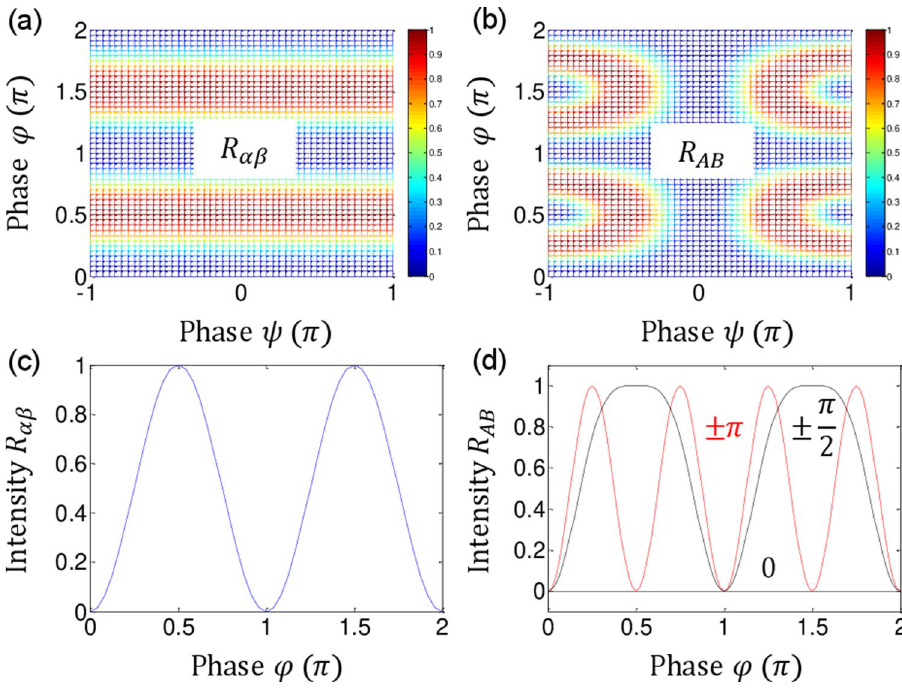
Figure 3. Numerical calculations for normalized intensity product R ij for Fig. 2. ( a ) R αβ . ( b ) R αβ . ( c ) R αβ for ψ = ± π . ( d ) R ψ = ± π( red ) , ψ = 0 ( dotted ) , ψ = ± π / 2 ( black ) . AB for